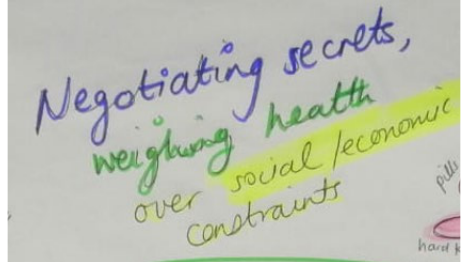
Figure 13. Economic and social